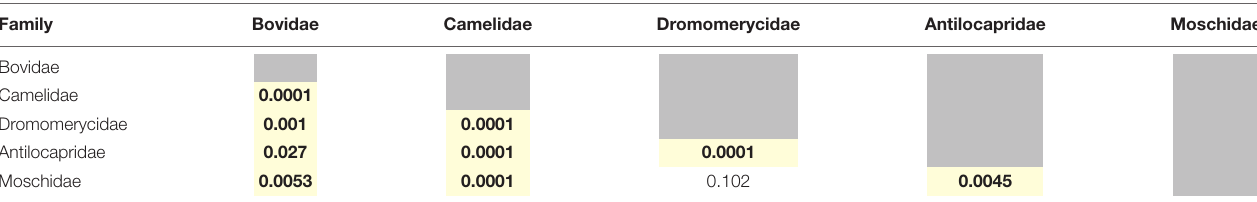
TABLE 4 | Summary of one way PERMANOVAs run with all row scores obtained from the correspondence analysis (permutation N = 9999) to test for differences between families (Bovidae includes only extant taxa, while all the other families include only extinct